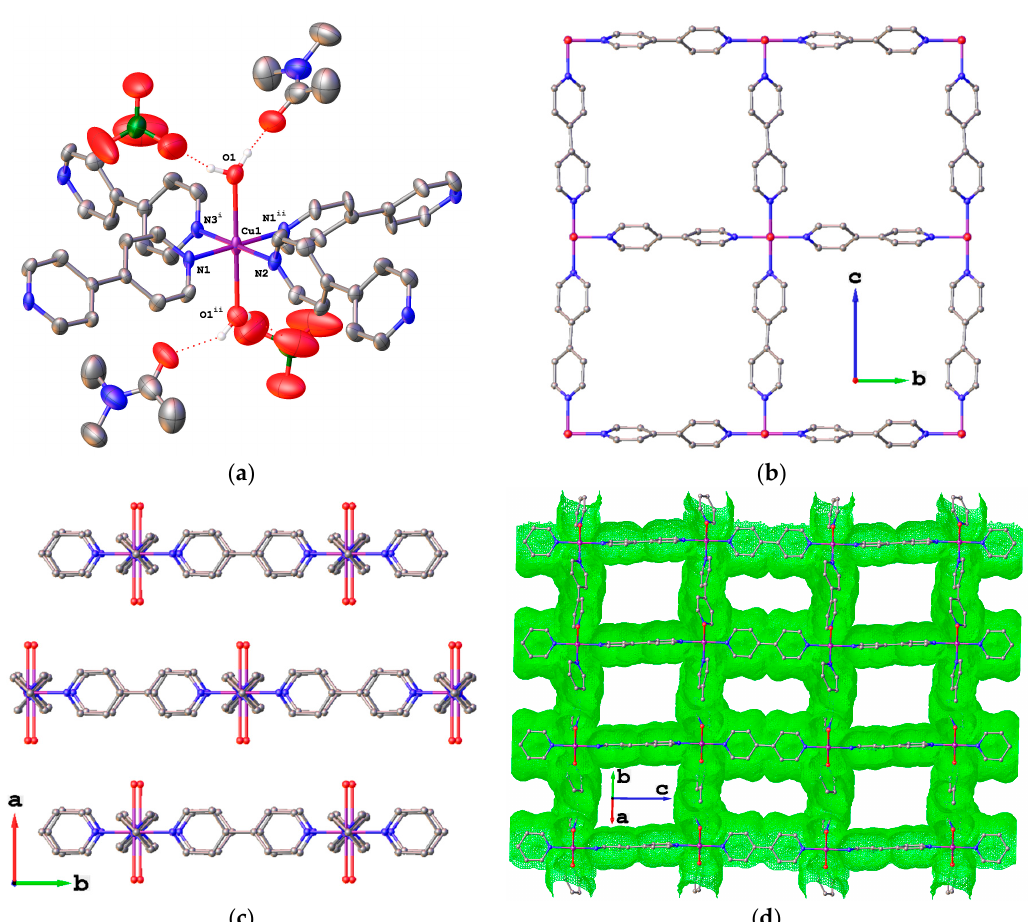
Figure 1. ( a ) Coordination environment of the copper center in compound 3 (thermal ellipsoids drawn at the 50% probability level). ( b ) 2D network (single layer); ( c ) view along the ab plane of alternating and mismatched grids; ( d ) channels formed by the 2D layers (green points). Color code: Cu, purple; O, red; N, blue; C, grey; Cl, green; H, white. Anions, DMA molecules and H atoms omitted for clarity in the packing figures. Symmetry operations: i = 1 − x , − 1 + y , 1 / 2 − z ; ii = 1 − x , + y , 1 / 2 − z